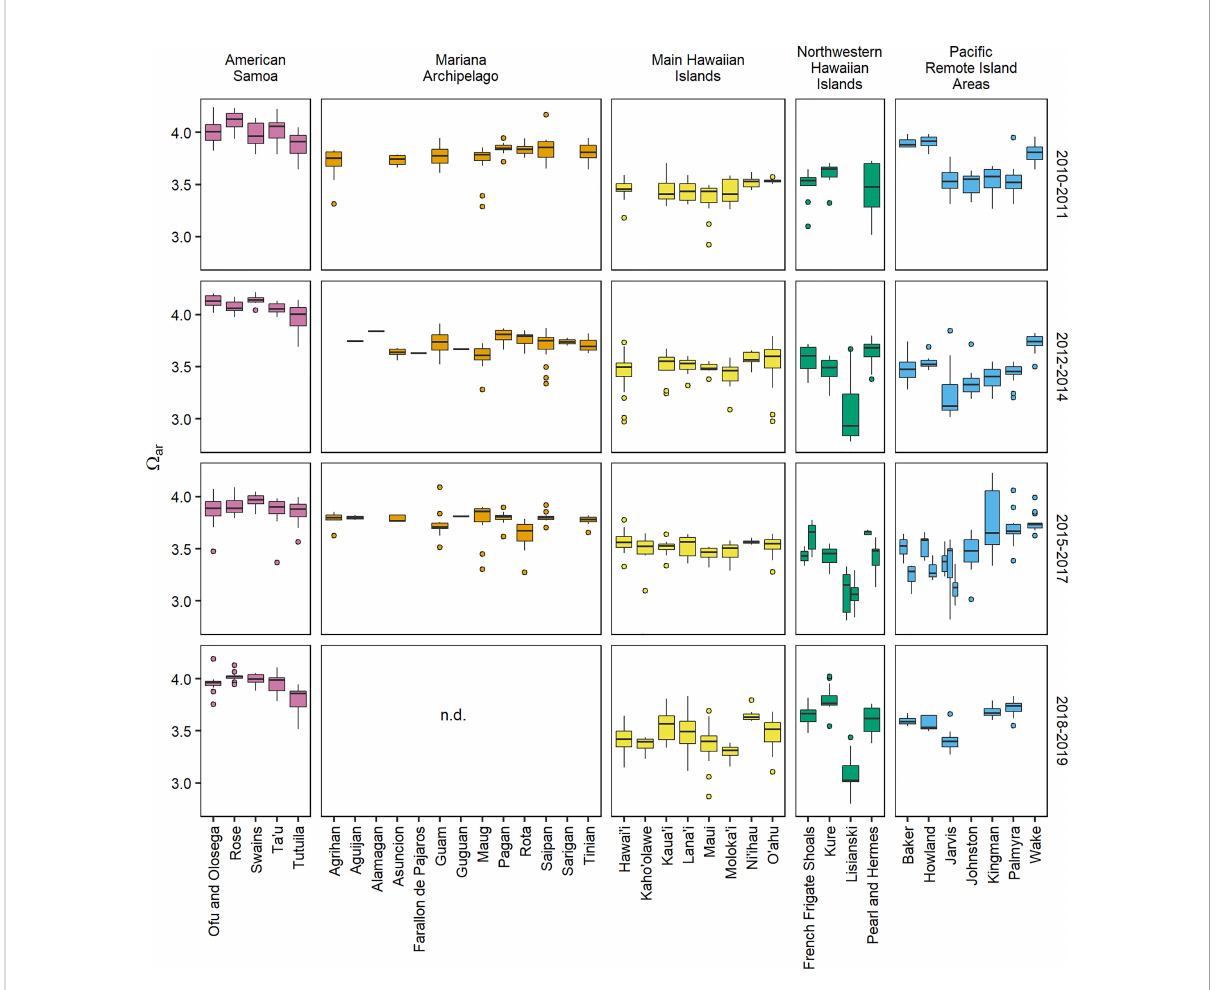
FIGURE 2 Aragonite saturation state ( W ar ) data for 37 U.S. Paci fi c islands and atolls collected during four sampling periods (2010 – 2011, 2012 – 2014, 2015 – 2017, and 2018 – 2019). 2018 – 2019 data are not available for the Mariana Archipelago due to COVID-19 ( “ n.d. ” = no data), and additional islands missing data were not sampled during the speci fi ed sampling period. Islands that were surveyed more than once during the 2015 – 2017 sampling period (French Frigate Shoals and Lisianski: 2015 and 2016, Howland and Baker: 2015 and 2017, Jarvis: 2015, 2016, and 2017) are shown with individual boxplots for each year. See Supplementary Figures 1 – 5 and Supplementary Tables 1 – 5 for a full description of sample collection years and carbonate chemistry parameter